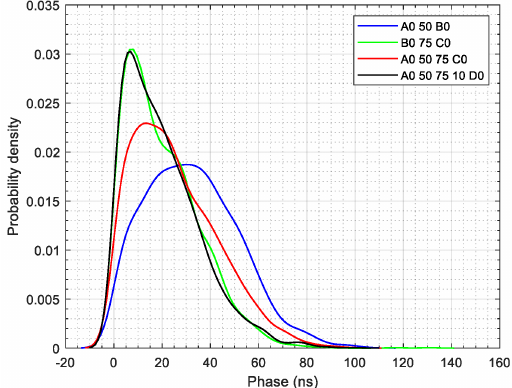
Figure 22. Distribution density for SAR with an LEM.